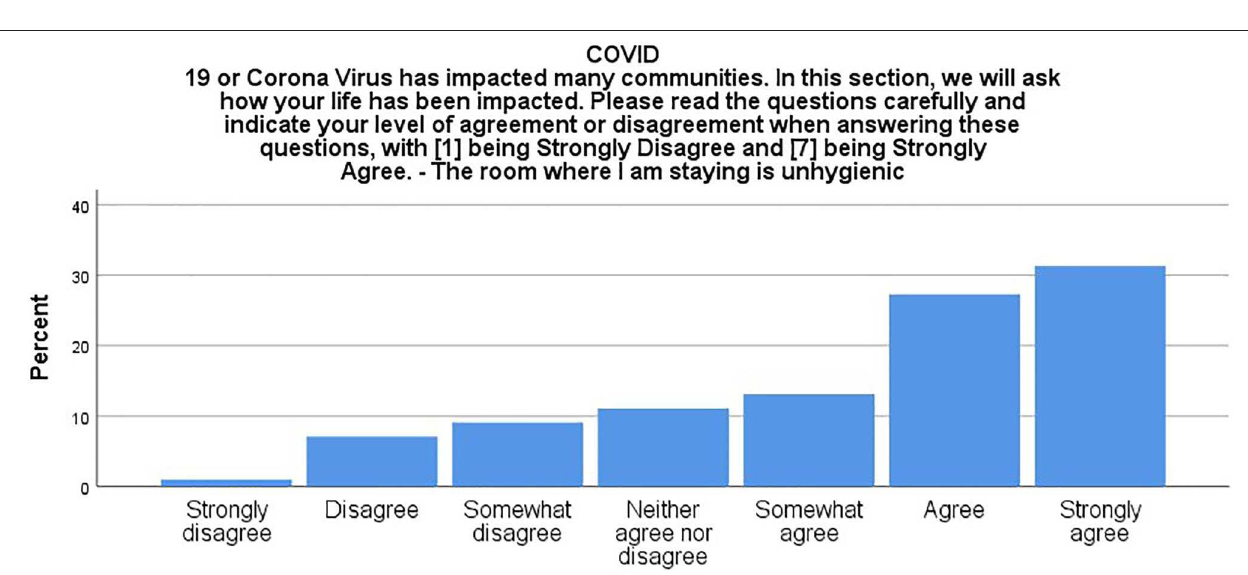
FIGURE 2 | Distribution of participants reporting inability to follow the one meter rule because of cramped conditions.